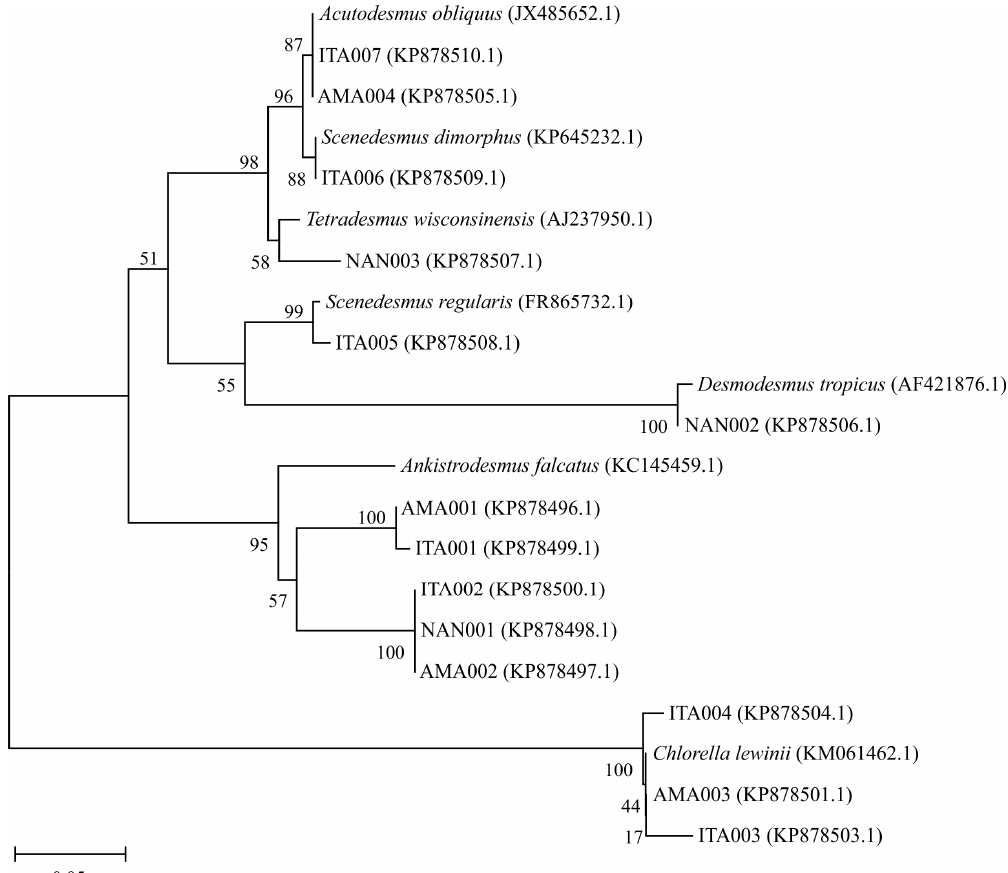
Figure 1. Unrooted phylogenetic tree of isolated microalgae strains using the ITS2 sequences. The tree was constructed by the neighbor-joining method and Kimura’s two-parameter algorithm in MEGA 6.0 software based on the multiple sequence alignment by Clustal Omega. Bootstrap values of 1000 replicates (%) are shown at the branches.